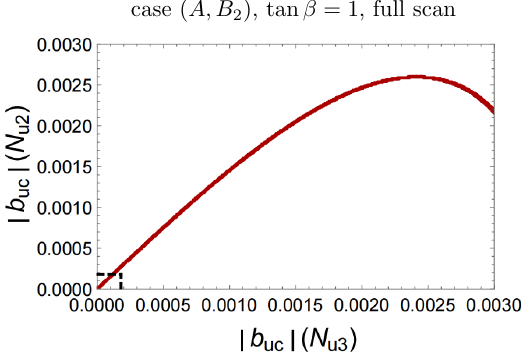
Figure 9 . The interplay between the values of | b uc | calculated from N u 2 and N u 3 in a full scan of case ( A, B ) 2